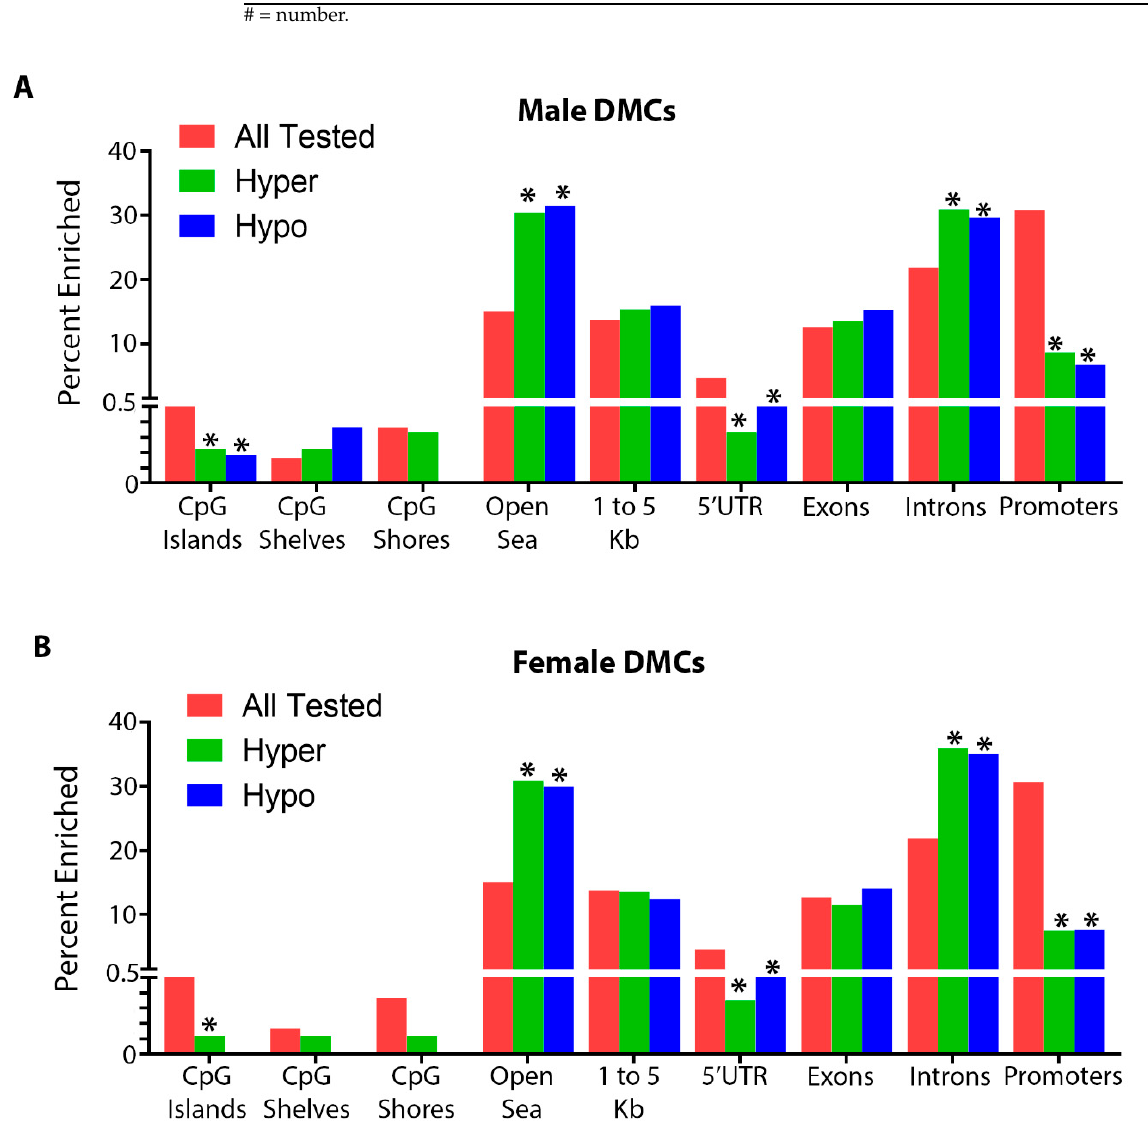
Figure 4. Annotation summary plots depicting the total number of CpGs tested in pink, hypermethylated differentially methylated cytosines (DMCs) in green, and hypomethylated DMCs in blue for each genomic annotation using the R annotatr package for males ( A ) and females ( B ). * Denotes statistically significance, p value < 0.05.